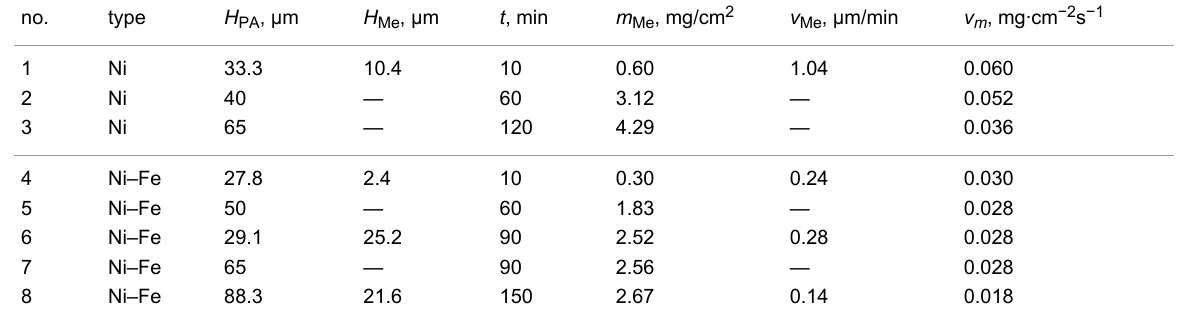
Table 2: The results of the galvanostatic dc deposition of Ni and Ni–Fe at a current density of 3 mA·cm -2 and varying H PA .